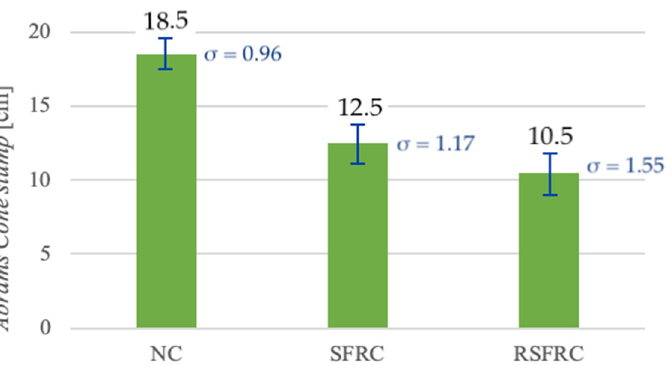
Figure 13. Comparison of the consistency test results with the cone slump test for mixtures without fibres (NC) and with steel fibres (SFRC and RSFRC).